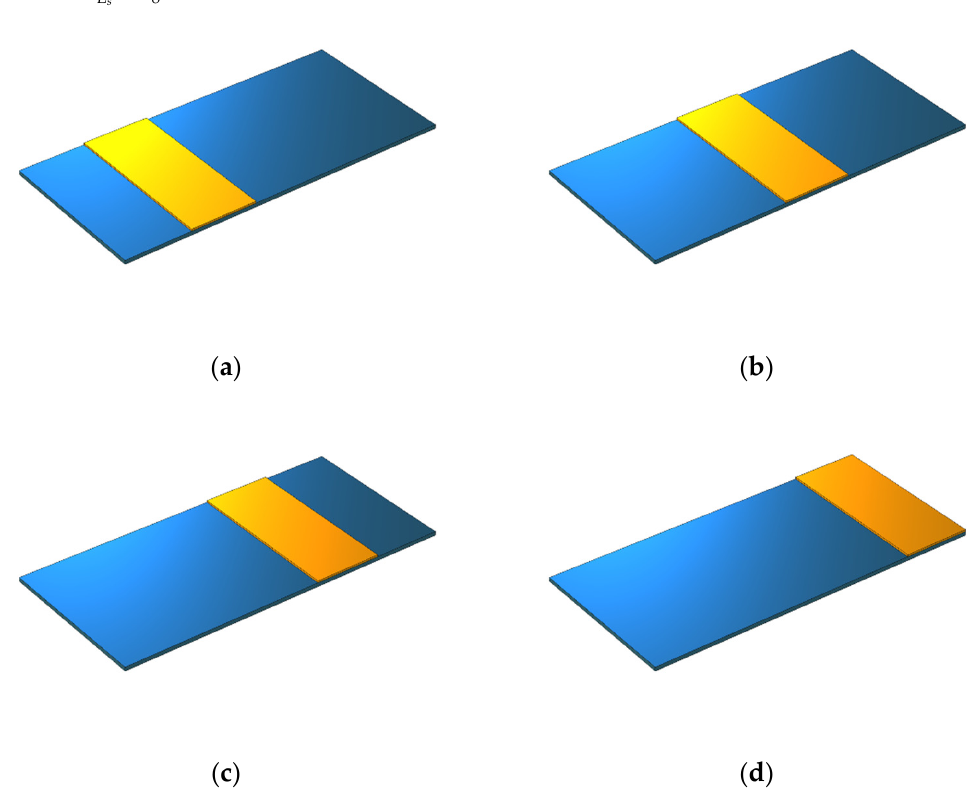
Figure 4. The geometric model of a rectangular beam while changing the position of the piezoelectric patch: ( a ) 𝑥 (cid:2868)(cid:3043) = 15 mm , ( b ) 𝑥 (cid:2868)(cid:3043) = 30 mm , ( c ) 𝑥 (cid:2868)(cid:3043) = 45 mm , and ( d ) 𝑥 (cid:2868)(cid:3043) = 60 mm .